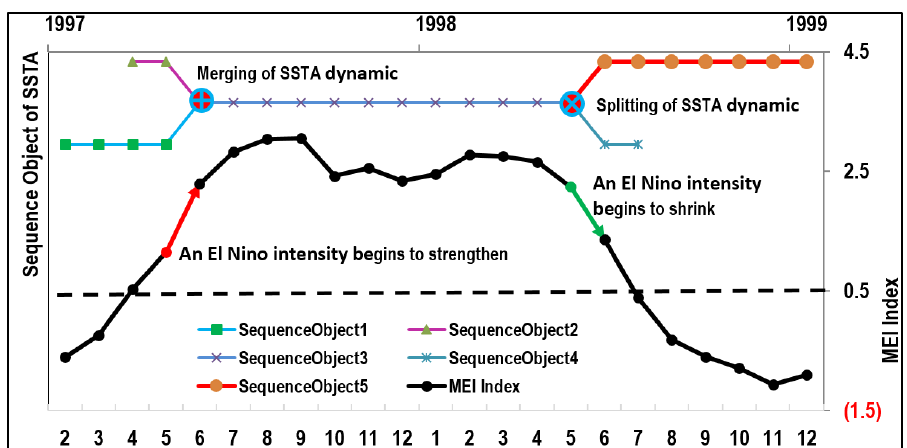
Figure 16. Relationship between the evolutionary of SSTA dynamic and an El Niño event.